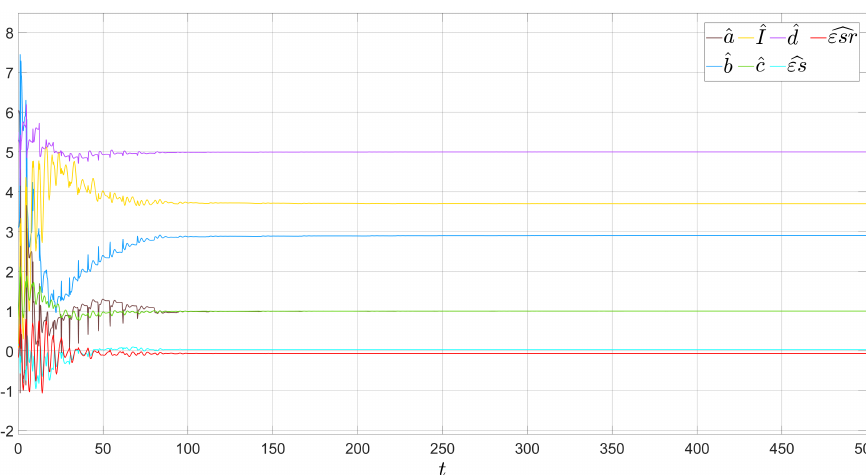
Figure 6. Identification process for bursting regime, γ = 1.